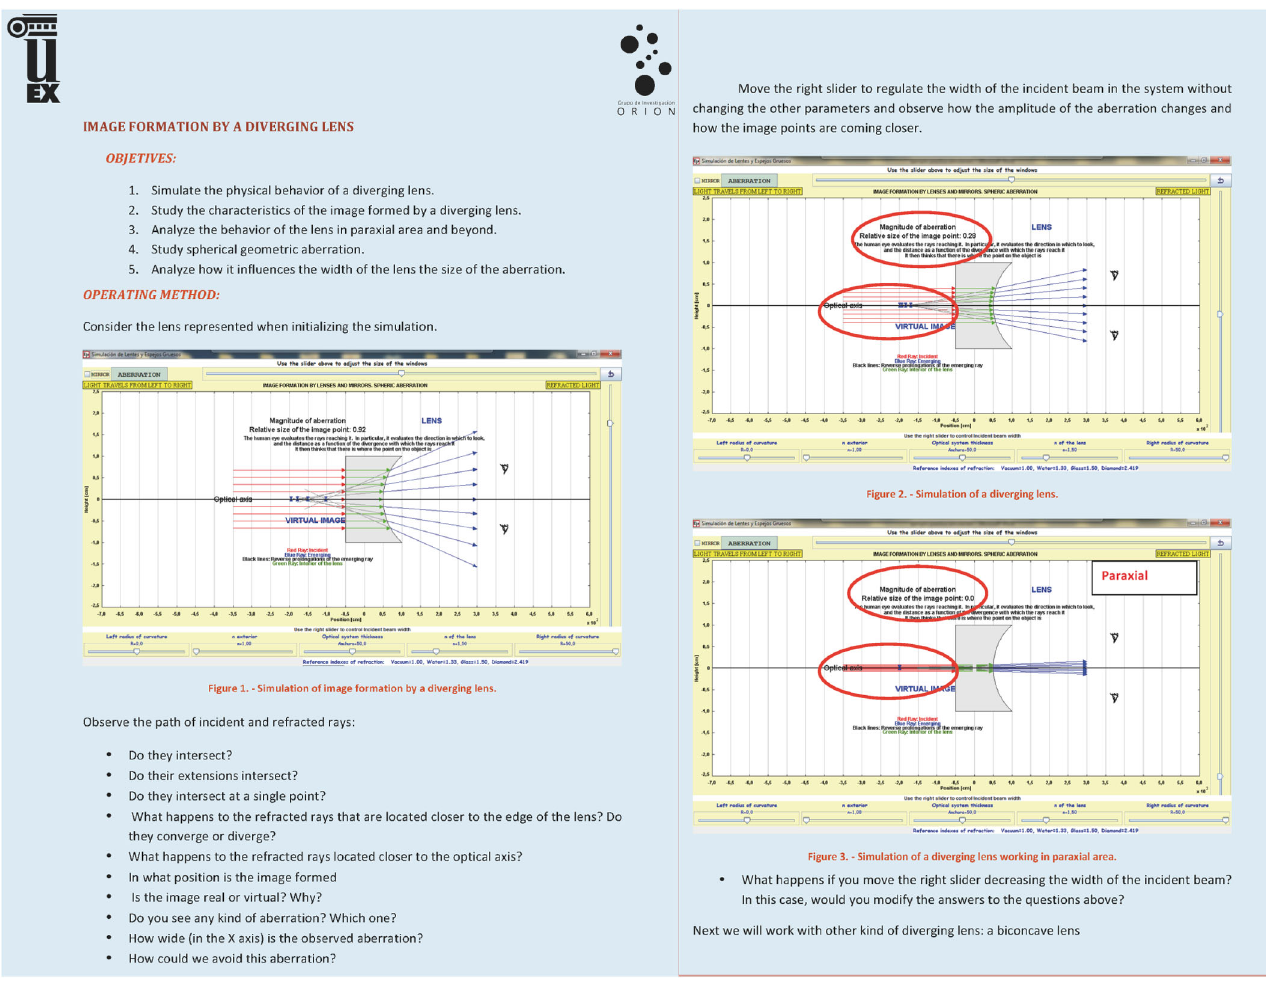
FIG. 2 (color online). Excerpt of the scripts provided to the